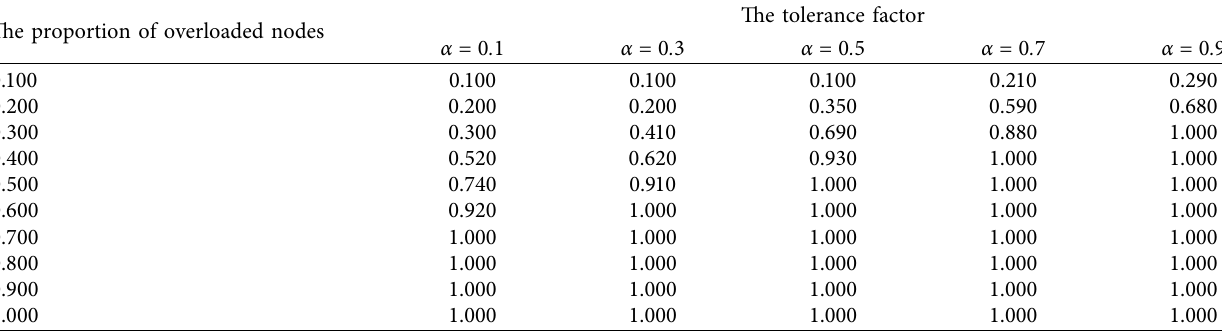
Table 10: The proportion of abnormal nodes (c).